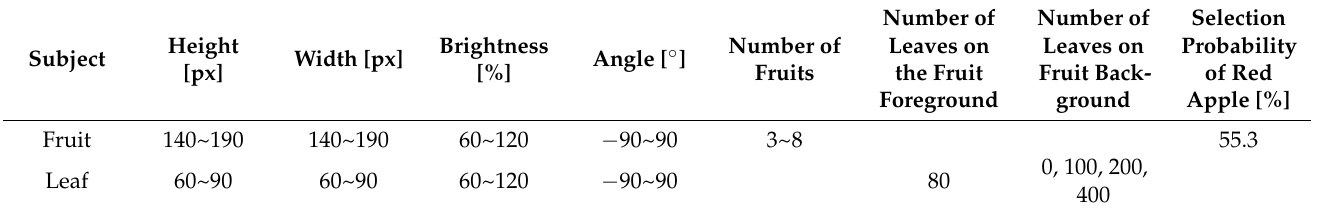
Table 1. Generation parameters. When placing the fruit and leaf images on a background image, the luminance, angle, magnification, and aspect ratio were randomly changed within an arbitrary range to increase the diversity of the training data.